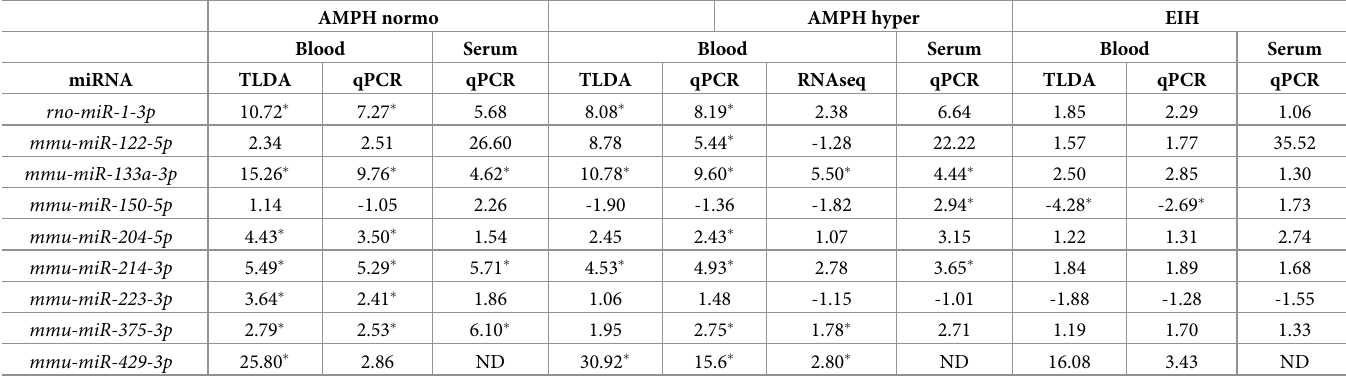
Table 2. Fold-change of selected miRNAs in the whole blood and serum of AMPH normo, AMPH hyper, and EIH groups relative to control.